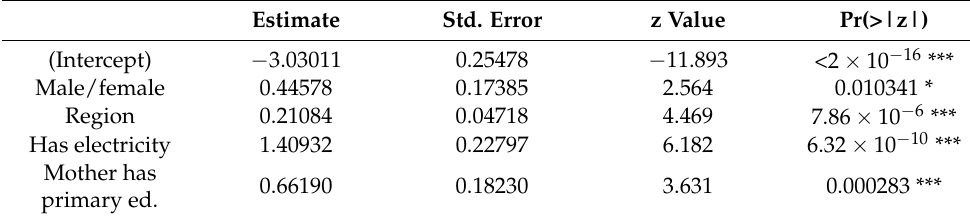
Table 3. Coefficients for best logistic regression model including all variables in Table 2. Estimate Std. Error